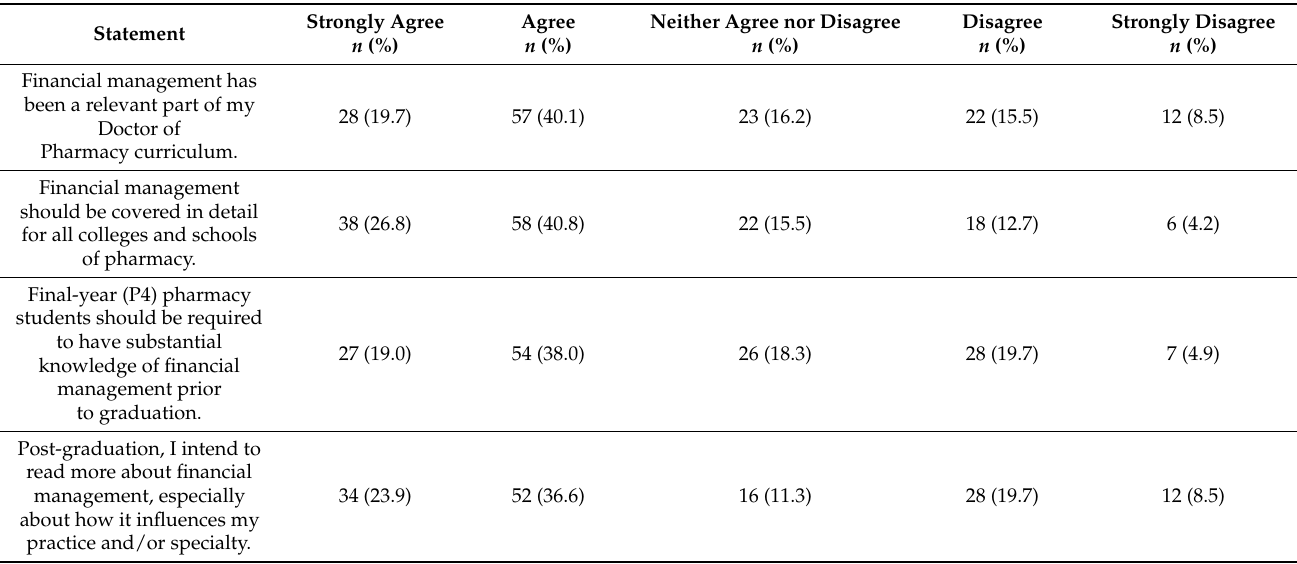
Table 4. Attitudes toward pharmacy financial management education ( n = 139).